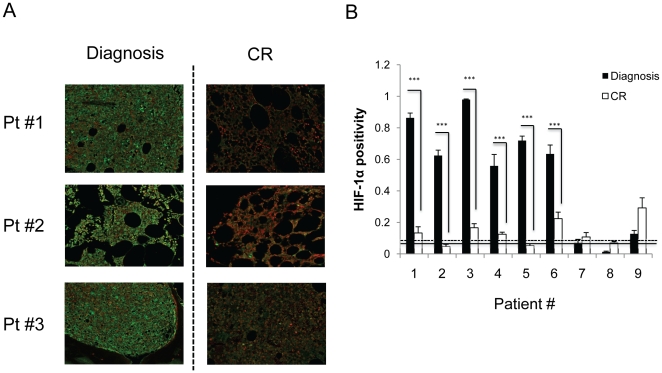
Expansion of the hypoxic BM niche in primary leukemia samples reverted following complete remission (CR).HIF-1α was detected by IHC in BM biopsies from 9 ALL patients at diagnosis and at CR after induction chemotherapy. (A) Representative images from 3 patients are shown. Original magnification, ×500. (B) Quantification of HIF-1α expression using Cri Inform software. A threshold was established based on the scores of three normal BM samples (continuous line represents average HIF-1α and dashed line correspond to SD for these 3 samples, respectively) CR; complete remission *** P<0.0001, error bars SEM.